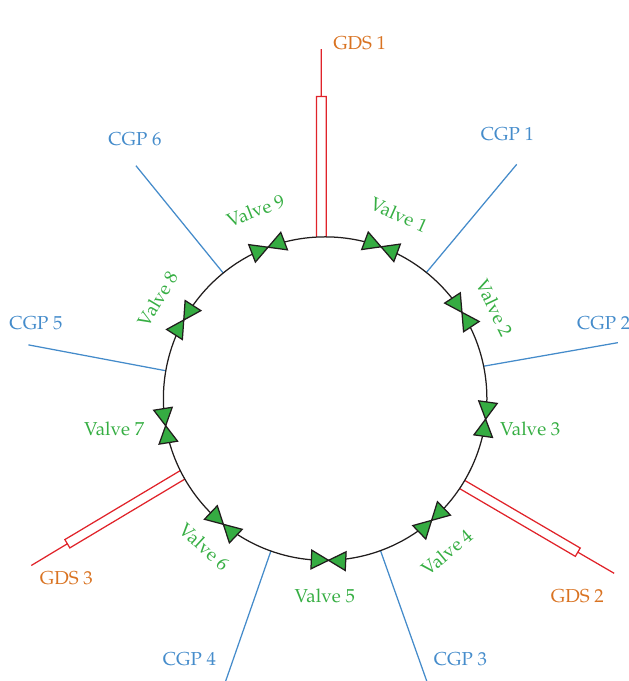
Figure 3: A testing diagram of the hypothesized gas distribution network.